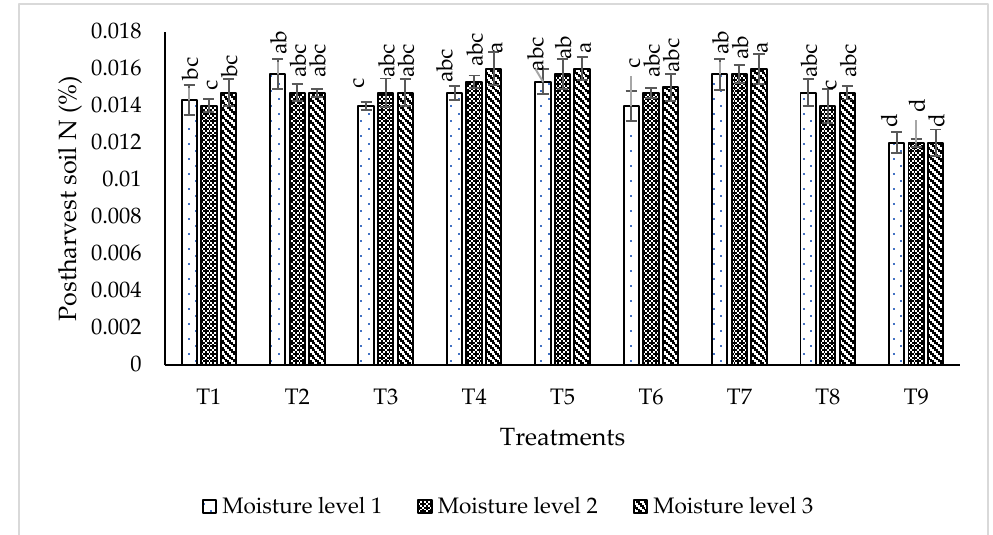
Figure 10. Effect of most efficient strains on post-harvest soil N (%) at different moisture levels in glass house experiment. The bars indicate standard error (± SE) of the mean ( n = 3). Means followed by the same letter within the bars are not significantly different at p = 0.05. T1 = RZ22 + RP01 + RS15, T2 = RZ11 + RP01 + RS14, T3 = RZ11 + RP08 + RS14, T4 = RZ11 + RP08 + RS15, T5 = RZ11 + RP01 + RS15,T6 = RZ22 + RP08 + RS14, T7 = RZ22 + RP08 + RS15, T8 = RZ22 + RP01 + RS14, T9 = control, where RZ11 = Mesorhizobium ciceri , RP08 = Enterobacter cloacae , RS14 = Bacillus mojavensis , RS15 = Providencia vermicola , RP01 = Bacillus subtilis , RZ22 = Mesorhizobium ciceri , Moisture level 1 = 55% of Field Capacity, Moisture level 2 = 75% of Field Capacity, Moisture level 3 = 95% of Field Capacity.